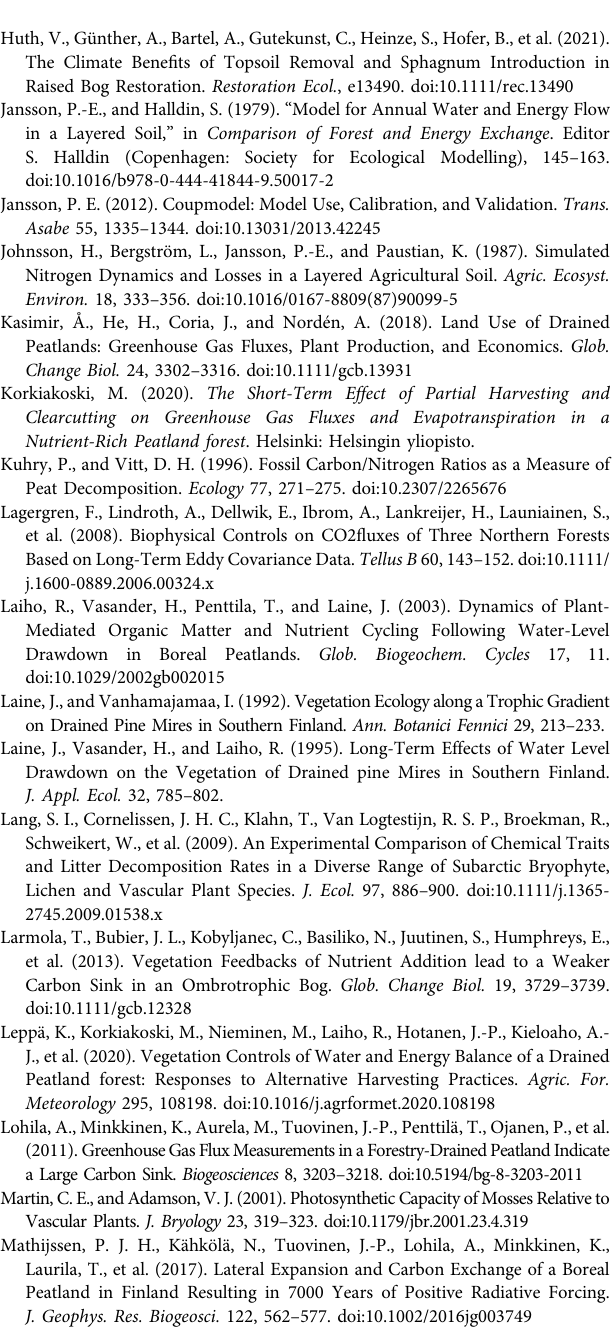
Table Drawdown. Nat. Clim. Change 11, 618 – 622. doi:10.1038/s41558-021-